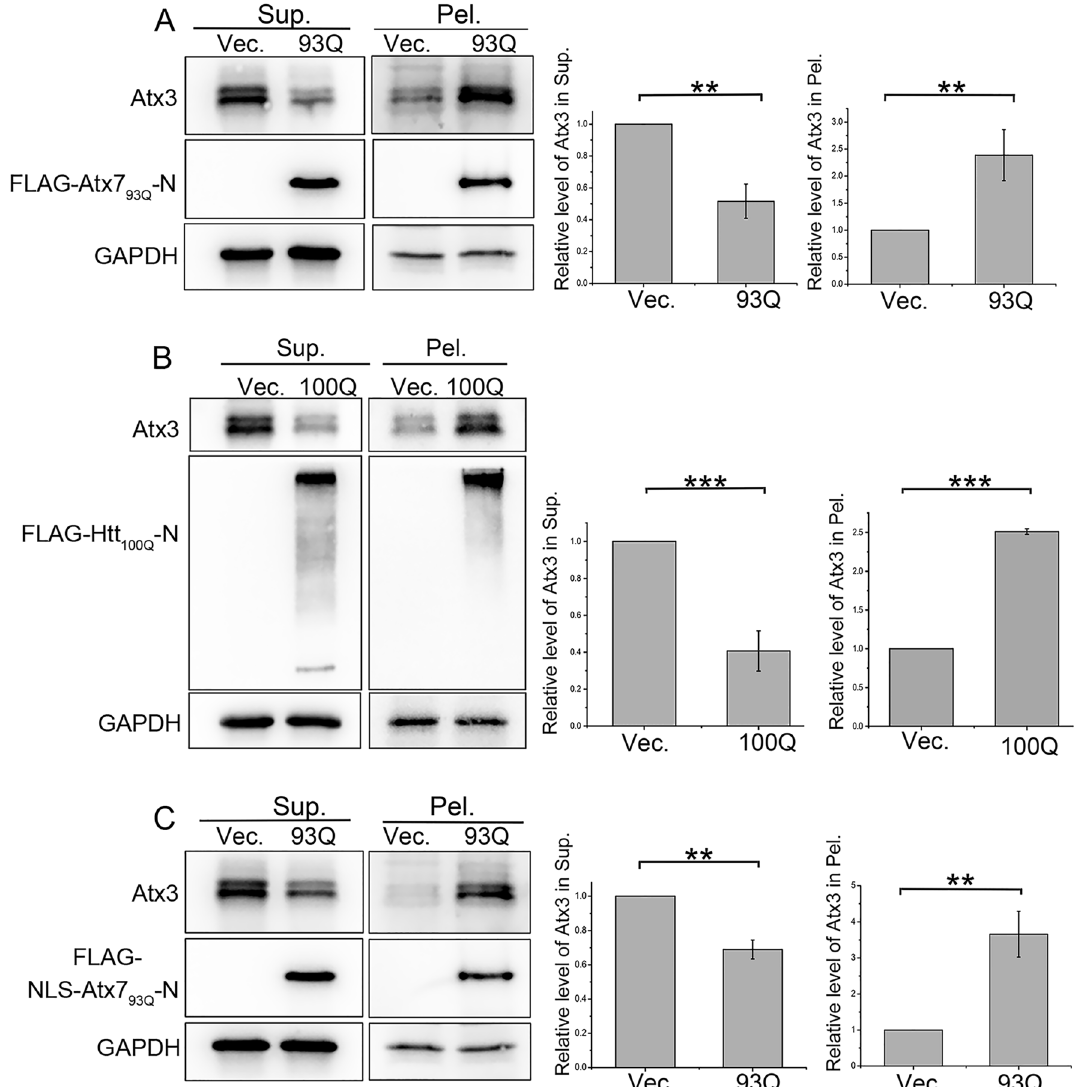
Figure 1. PQE Atx7 and Htt reduce the soluble fraction of intracellular Atx3 but increase the insoluble. ( A ) Effects of cytoplasm-localized Atx7 93Q -N172 on the supernatant and pellet fractions of Atx3. ( B ) As in ( A ), cytoplasm-localized Htt 100Q -N90. ( C ) As in ( A ), nucleus-localized NLS-Atx7 93Q -N172. HEK 293T cells were transfected with each indicated plasmid and the cell lysates were subjected to supernatant/pellet fractionation and Western blotting analysis. Indicated proteins were detected by using anti-FLAG, anti-Atx3 and anti- GAPDH antibodies. The two main bands indicate different isoforms of endogenous Atx3, Atx3-I and Atx3-II. Sup., supernatant; Pel., pellet. The gray values of Atx3 protein bands from three independent experiments were employed for statistical analysis. Data are shown as Means ± SEM (n = 3). ** p < 0.01; *** p <